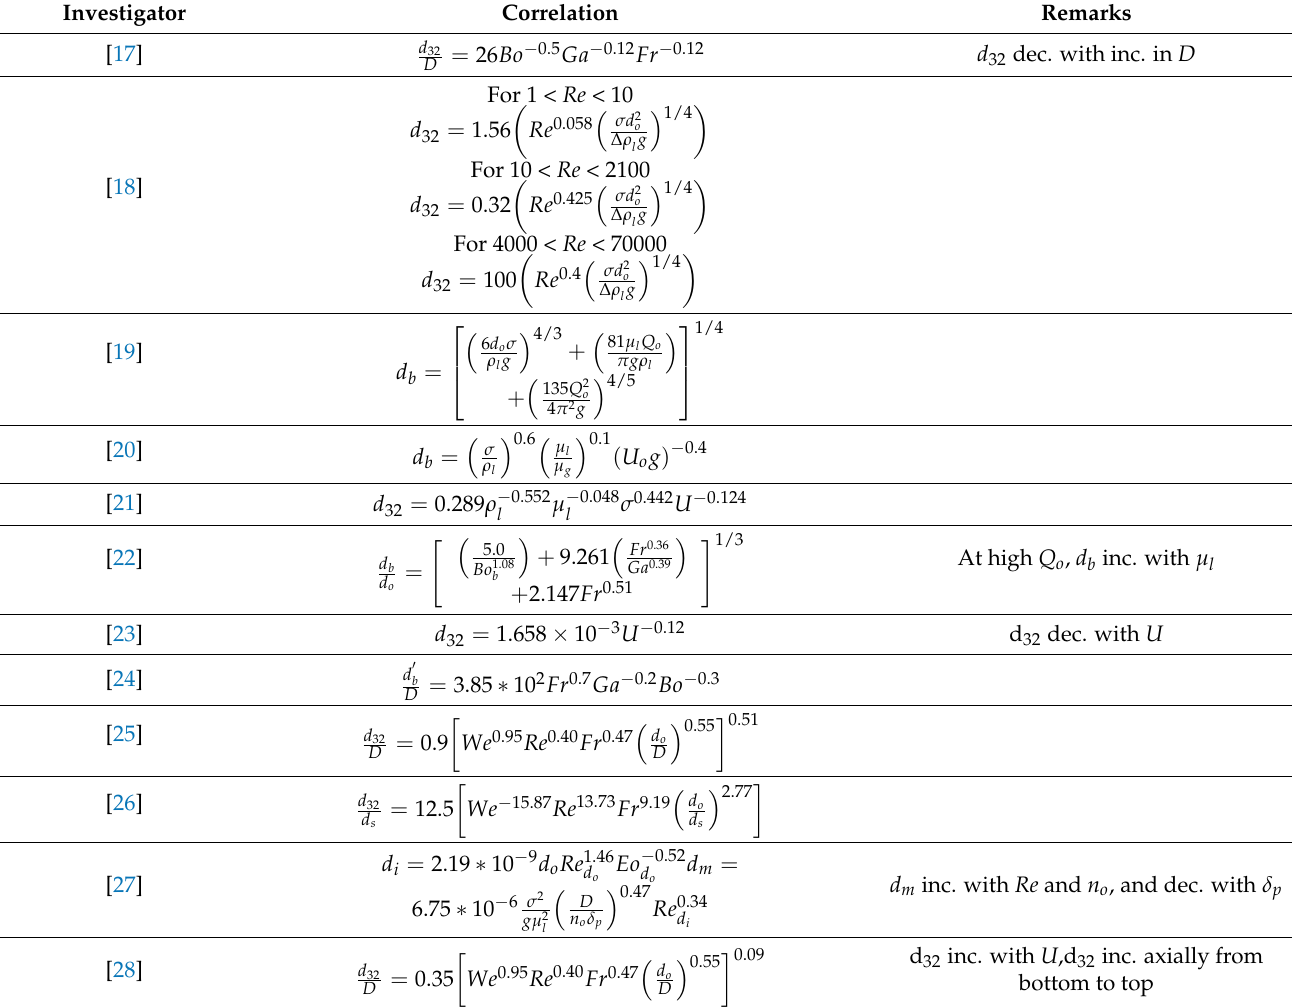
Table 1. Correlations for bubble diameter, d 32 , in bubble